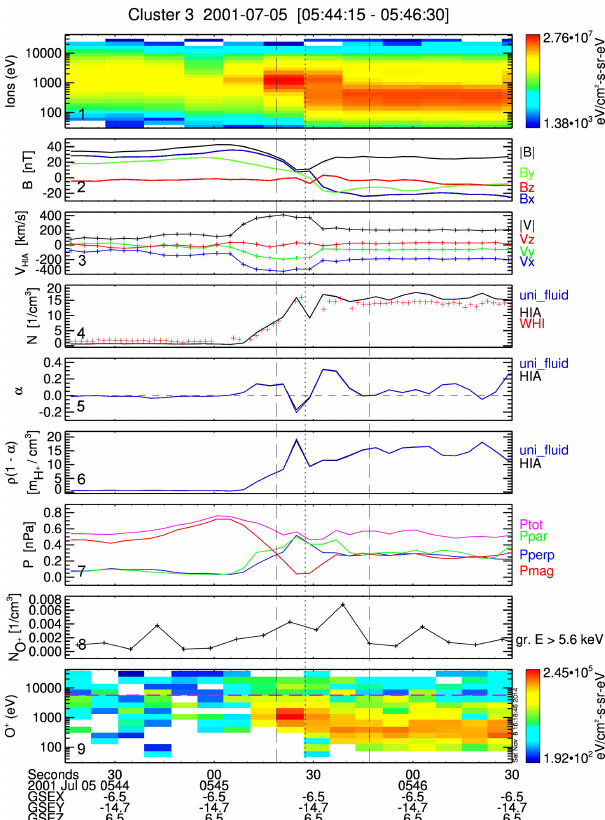
Figure 4. Plasma and magnetic field parameters for an outbound magnetopause crossing on 5 July 2001 as measured by Cluster 3. The layout is the same as in Fig.